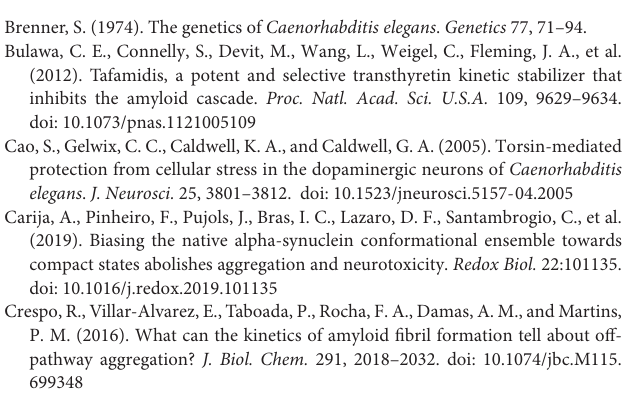
FIGURE S1 | α -Synuclein soluble fraction at the end of the aggregation. (A) Soluble fraction of α -Syn when incubated in absence (black) or presence (green) of ZPD-2 in PBS solution. (B) Soluble fraction of strains B and C at final point of the aggregation when incubated in presence (green) or absence (black) of ZPD-2. FIGURE S2 | Lack of interaction between monomeric α -synuclein and ZPD-2 assessed by NMR. Superposition of the 1H-15N HSQC NMR spectra of 15N-labeled α -Syn (70 µ M) in absence (black) and presence (green) of 100 µ M of ZPD-2. FIGURE S3 | PMCA assay at early stages. Tricine–SDS-PAGE gels of untreated (middle) and ZPD-2-treated (right) PMCA samples before ( − ) and after ( + ) being digested with proteinase K. Soluble α -Syn and PMCA steps 1–3 are shown. FIGURE S4 | Toxicity assays. Analysis of neuronal cells culture survival in presence of different concentration of ZPD-2. Survival is potted as normalized means. Error bars are shown as standard error of means values, where p < 0.001 was indicated by ∗∗∗ . FIGURE S5 | C. elegans lifespan analysis. Effect of ZPD-2 treatment (green) on the survival of PD model animals, in comparison with untreated PD worms (black). The data represent the survival ratio (approximately 60–80 animals per group). FIGURE S6 | Distribution of functional neurons in the C. elegans dopaminergic model. Normal distribution of the remaining functional dopaminergic (DA) neurons in transgenic animals when treated with ZPD-2 (green) or vehicle (gray). The dashed line delimits animals having four or more functional DA